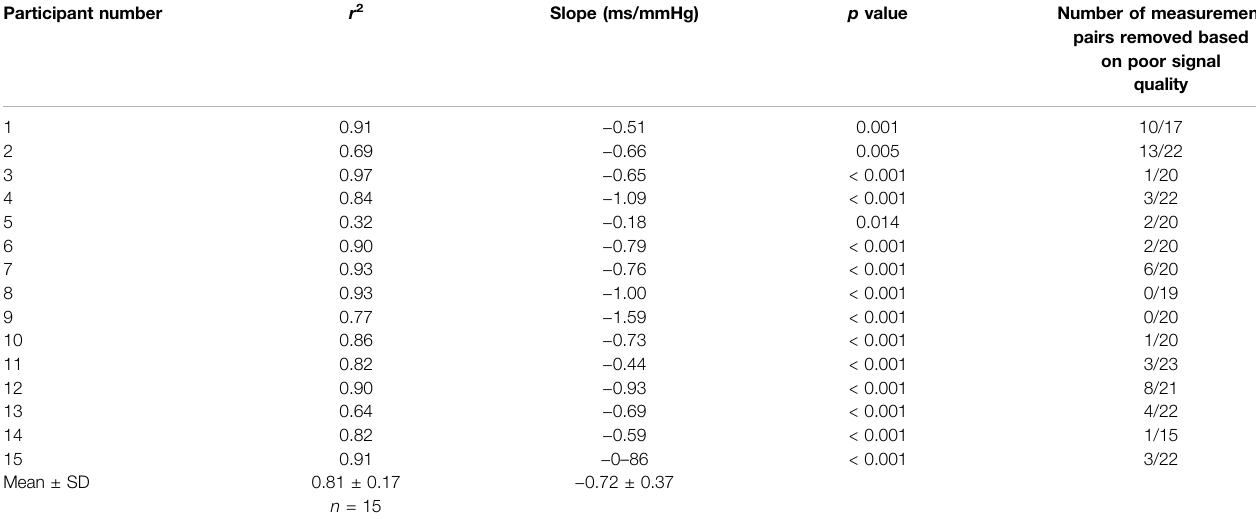
TABLE2| Linearregressionbetweensystolicbloodpressure(SBP)andpulsearrivaltime(PAT)forparticipantswithvalidpulsearrivaltime(PAT)measurements.The p value indicates the test of the null hypothesis that the coef fi cients are equal to zero. Participant number